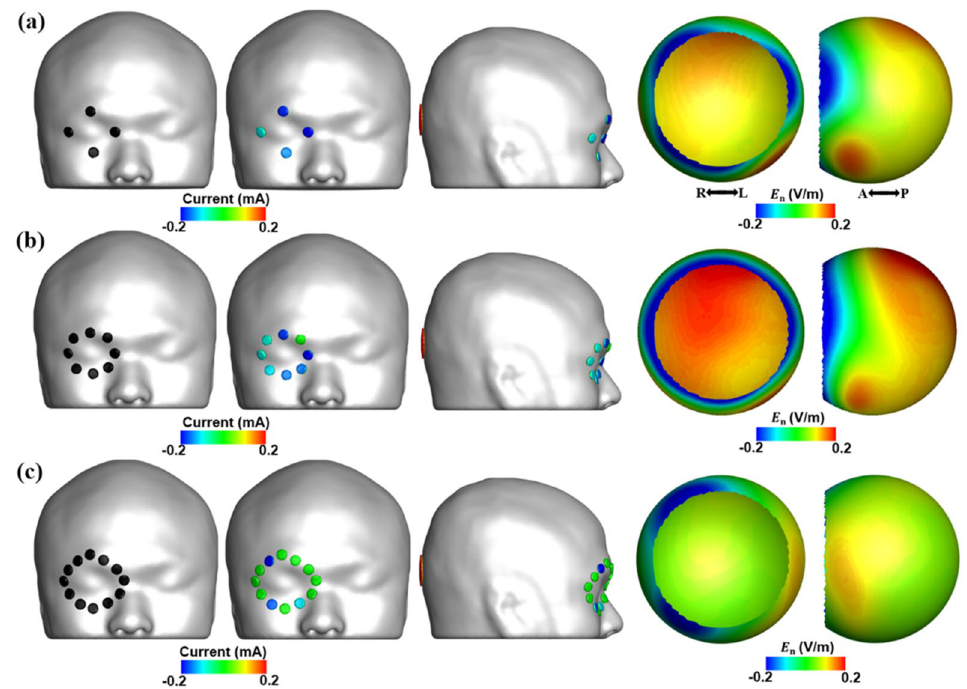
Figure 8. Injection current pattern and electric field distribution in the retinal surface when applying ( a ) an electrode montage with 4 active electrodes, ( b ) the suggested electrode montage with eight active electrodes, and ( c ) an electrode montage with 12 active electrodes. For each montage, optimal injection currents were found from the optimization procedure. E n represents the electric field in the direction normal to the retina surface.